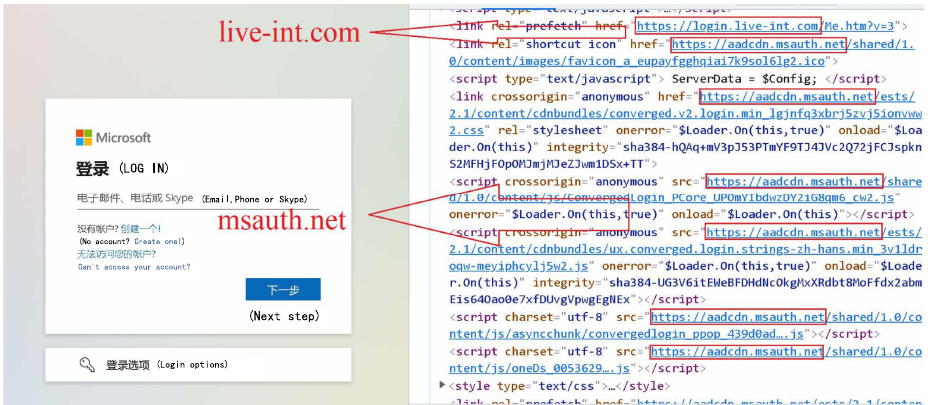
Figure 2. Example of a phishing